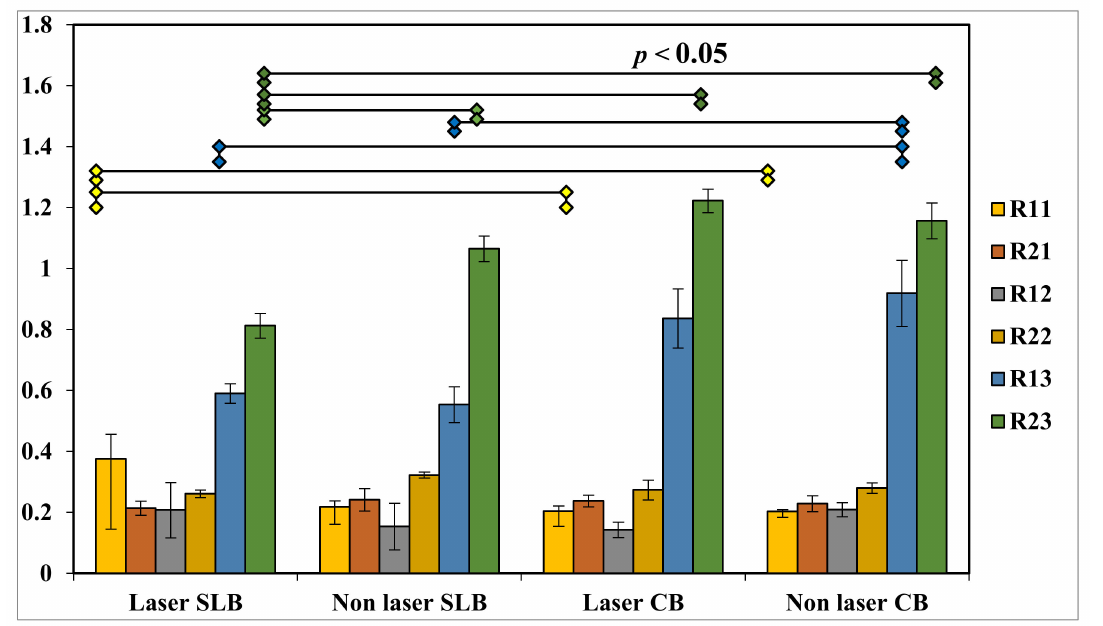
Figure 5. Graphical representation of Tukey’s post-hoc test results for intra-group